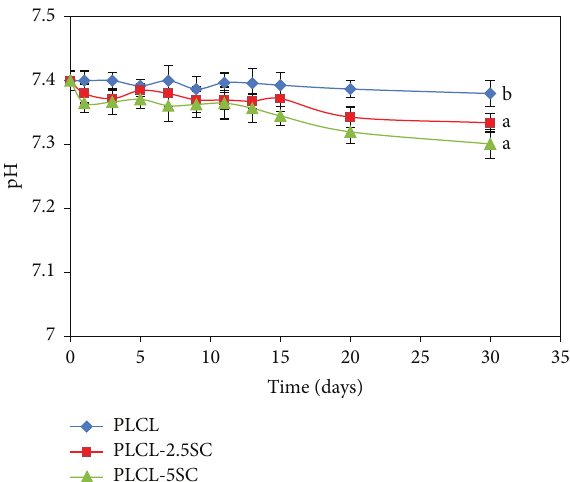
Figure 6: pH changing profile of the membranes submerged in PBS for 30 days at 37 ± 1.0 ∘ C. Statistical differences between each group are represented as the lowercase letters (a, b) ( 𝑝 ≤ 0.05 ).